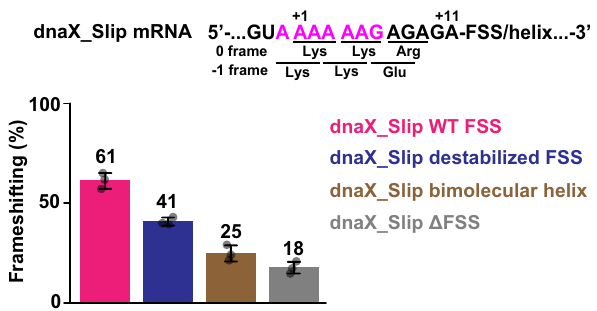
Fig. 9 The presence of the loop is more important for the FSS-stimulated − 1 PRF than the local and overall thermodynamic stabilities of the FSS. Ribosomes containing P-site N -Ac-Val-tRNA Val were programmed with dnaX_Slip mRNA containing an FSS variant (Fig. 1). The ribosomes were incubated with EF-G (cid:129) GTP, EF-Tu (cid:129) GTP, Lys-tRNA Lys and [ 3 H]Glu-tRNA Glu (decodes GAG codon in − 1 frame) for 5 min. For each FSS variant, [ 3 H]Glu- tRNA Glu binding to the ribosomal A site was measured by fi lter-binding assays. Frameshifting ef fi ciency is represented by A-site occupancy by [ 3 H] Glu-tRNA Glu normalized by the P-site occupancy of N -Ac-[ 3 H]Glu- tRNA Glu , which non-enzymatically binds to the ribosome programmed with dnaX_Slip Δ FSS mRNA. Data are presented as mean values± standard deviations of three independent measurements. Source data are provided as a Source Data fi